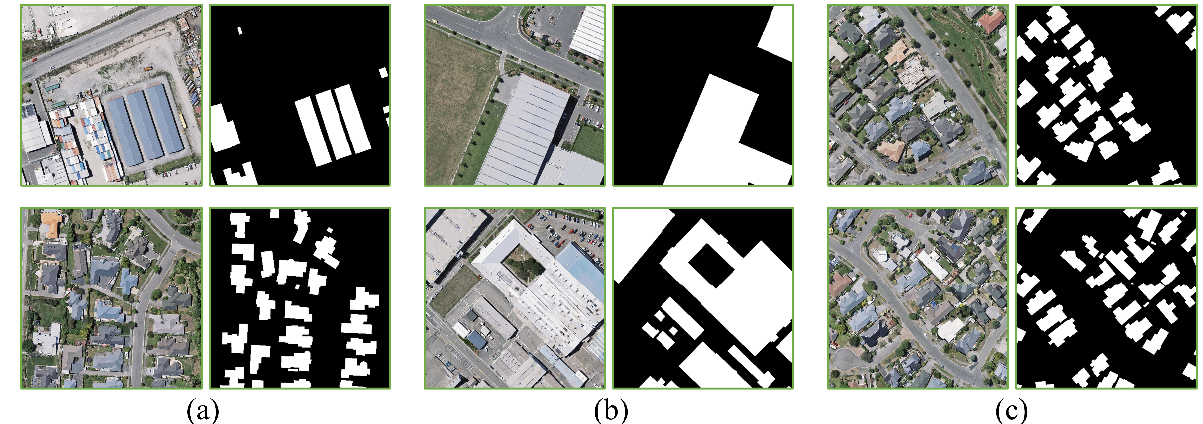
Figure 6. Examples of the original images and the ground truth of the WHU building dataset. ( a ), ( b ), and ( c ) are training, validation, and testing samples, respectively.